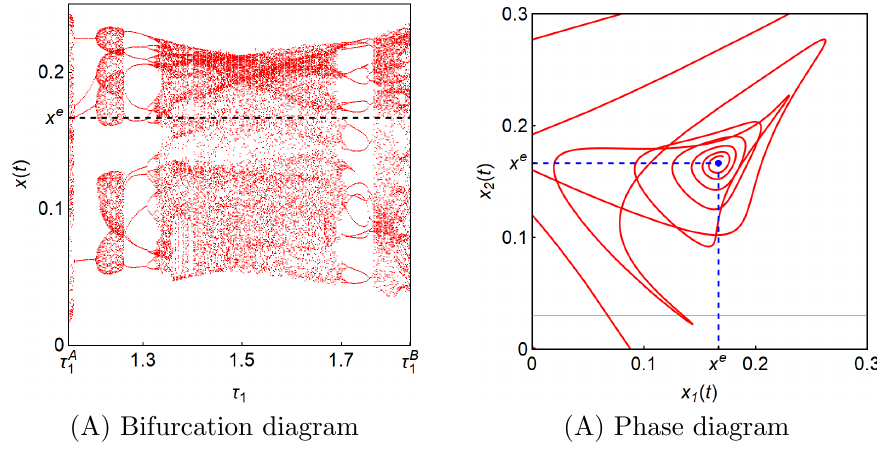
Figure 7. Possible global dynamics for various values of τ 1 > τ A